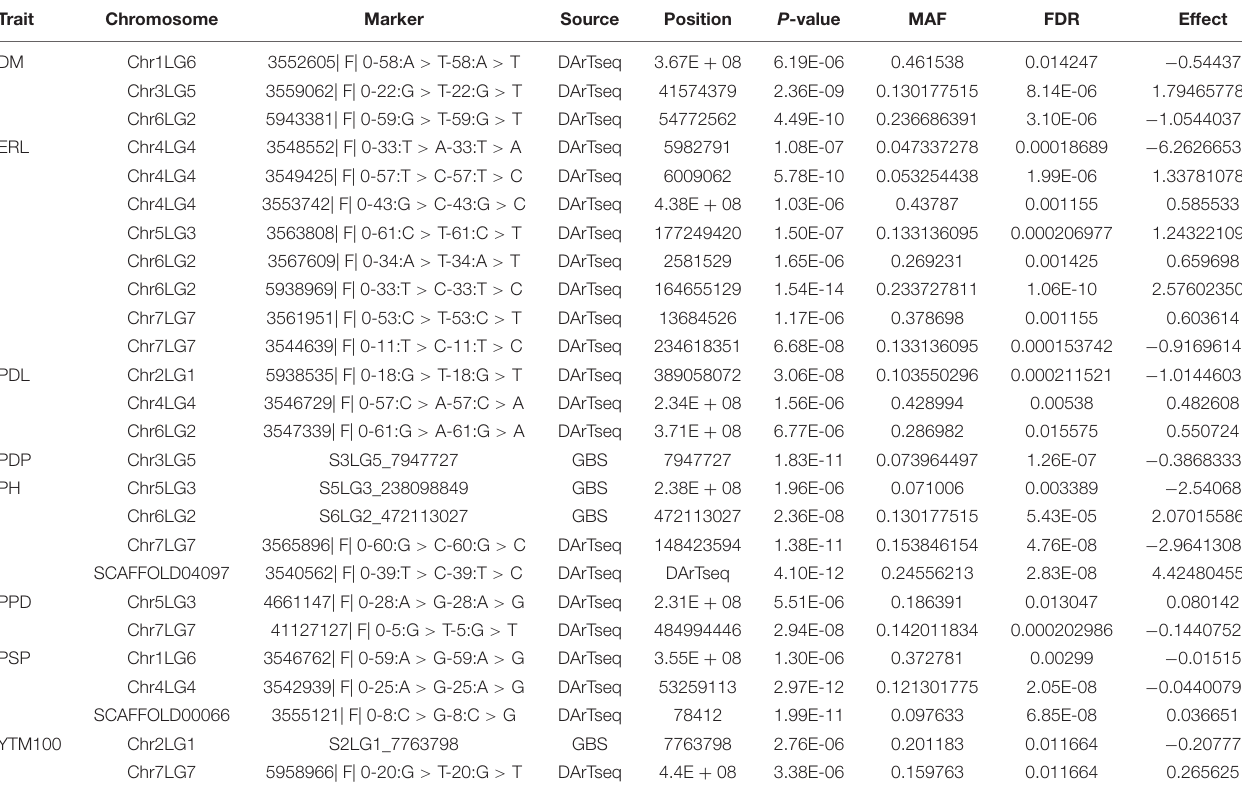
FIGURE 4 | Genome-wide linkage disequilibrium (LD) decay curve in a scatter plot of pairwise SNPs r 2 values against the physical distance (bP). The blue curve line is the smoothing spline regression model fitted to LD decay, the horizontal orange solid line is the half-LD decay of the genome ( r 2 = 0.23), and the vertical green solid line is the genetic distance (6.93 Mbp) of the intersect between the r 2 value of the half-LD decay and the LD decay curve. TABLE 2 | List of above Bonferroni threshold significant SNP markers associated with agronomic and downy mildew resistance traits in wrinkled wining pea. Trait